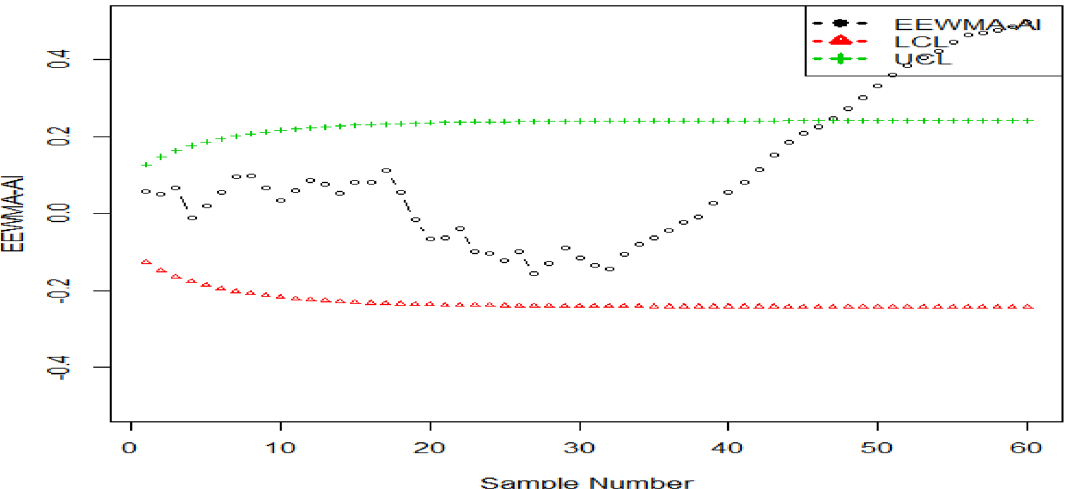
Figure 1. The suggested EEWMA-RE control chart for simulated data.